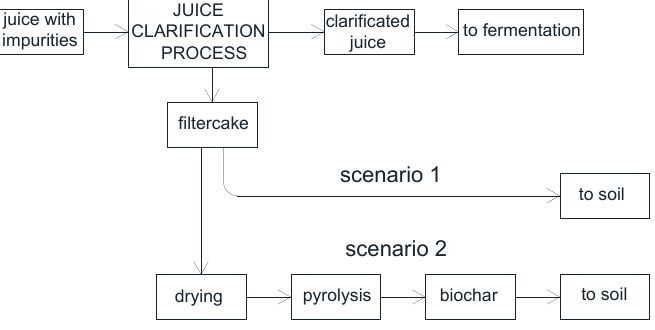
Figure 4. Obtention and destinations of the filtercake.